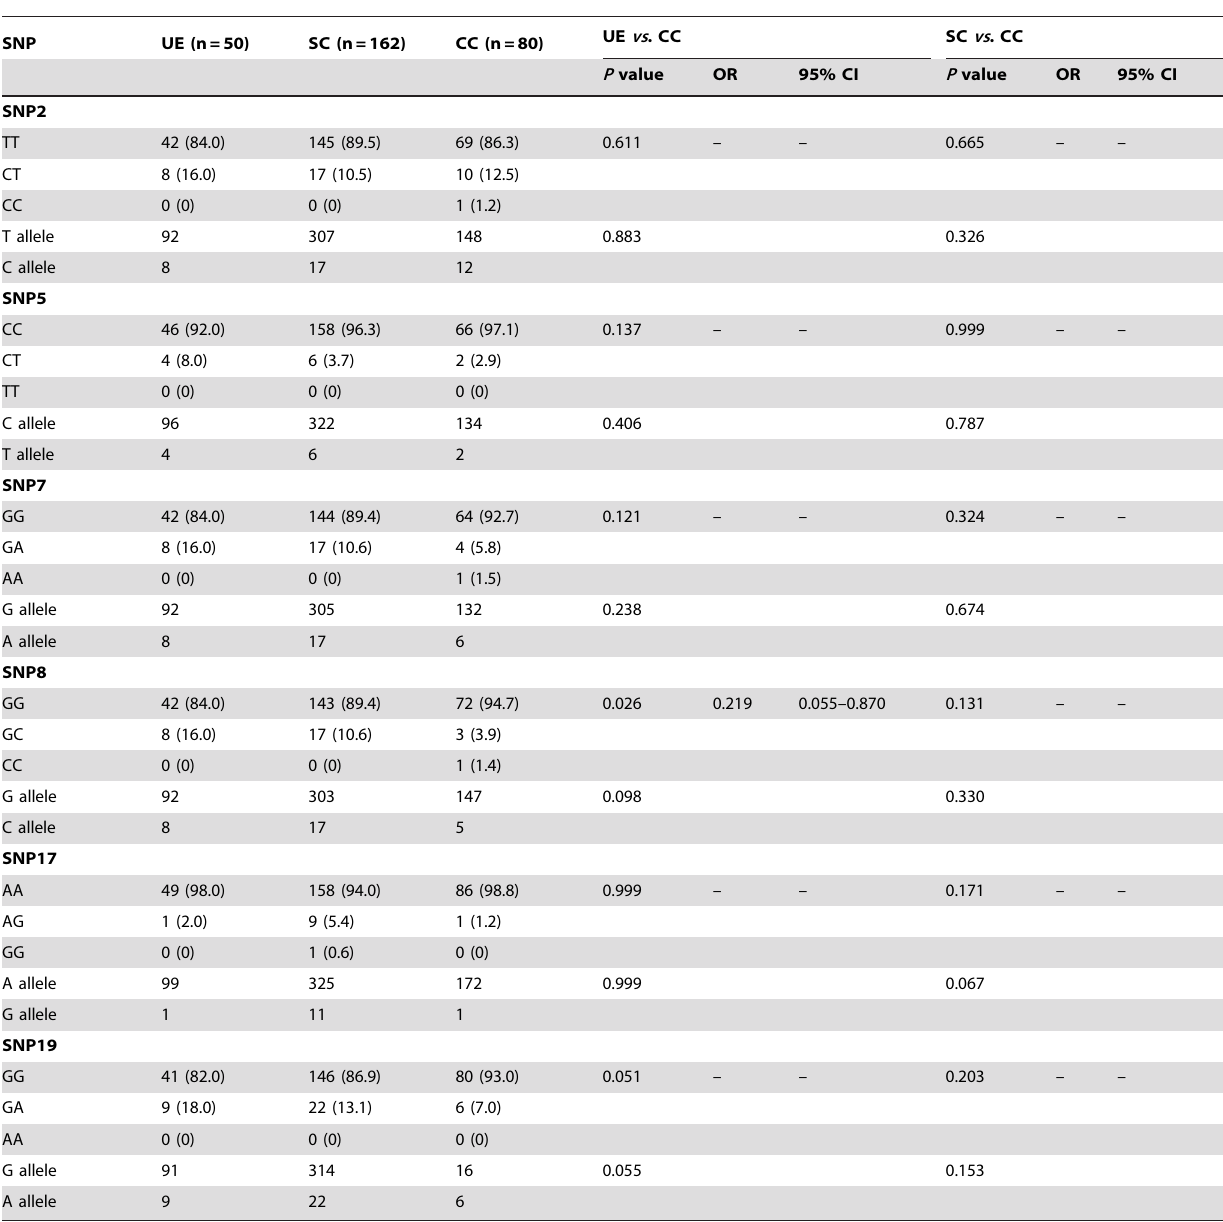
Table 3. Prevalence of newly identified six SNPs in IL28B gene in UE, SC, and CC